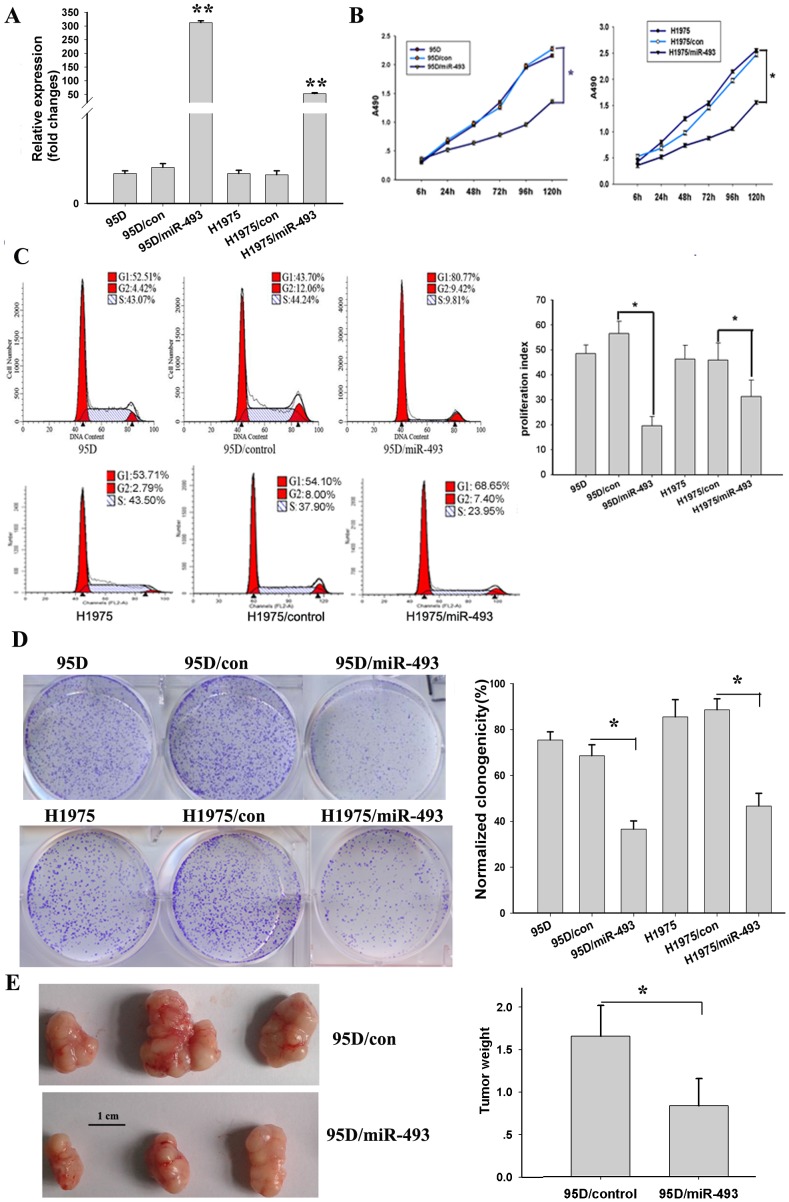
Ectopic expression of miR-493 in lung cancer cells inhibits proliferation.A, stable ectopic overexpression of miR-493 was generated in cell subsets 95D/miR-493 and H1975/miR-493. qRT-PCR was used to verify the transfection. ** means P<0.001 (t-test). B, growth curves demonstrated that the lung cells were capable of proliferation. Cells were seeded in 12-well plates at the desired cell concentrations and maintained in medium containing 10% FBS. The absorption value of cells was measured at the indicated time points in triplicate and their growth rates were recorded. * means P<0.05 (t-test). C, The cells cycle's distribution of lung cancer cells was analyzed with a FACScan flow cytometer. The proliferation index (PI) was used to describe the potentiality of cell proliferation. PI = G2+S fraction)/(G1+G2+S)×100%. Left, the representative image of cell cycle percentage changing. Right, the statistical analysis of cell cycle percentage, data are presented as mean± SEM of 3 independent experiments * means P<0.05 (t-test). D, colony formation assays were used to determine the effect of miR-493 on long-term cell survival. Left, the area covered on each plate by the colonies was measured using an imaging system and represented as the percentage of the total area of the plate. Right, the effect of miR-493 overexpression on colony formation of lung cancer cells: each column represents a mean value of triplicate experiments in each group. Data are mean ± SEM. * means P<0.05 (t-test). E, miR-493 inhibited pulmonary tumor growth in mouse xenograft models (12 animals). Left, representative tumors isolated from mice 25 days after the subcutaneous injection of 95D cells that were stably transfected with the miR-493-expressing or control vector. Right, Data are mean ± SEM. * p<0.05, (t test).